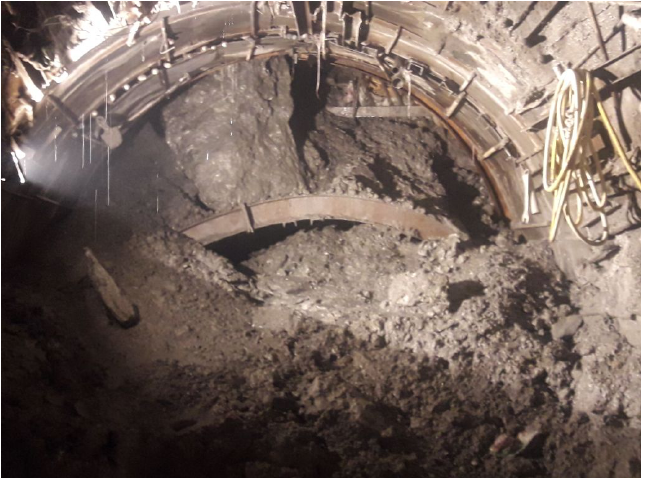
Figure 7. Partially sank ISMB 150 in the soft ground at chainage 330 m (DKHP), which was partially removed by